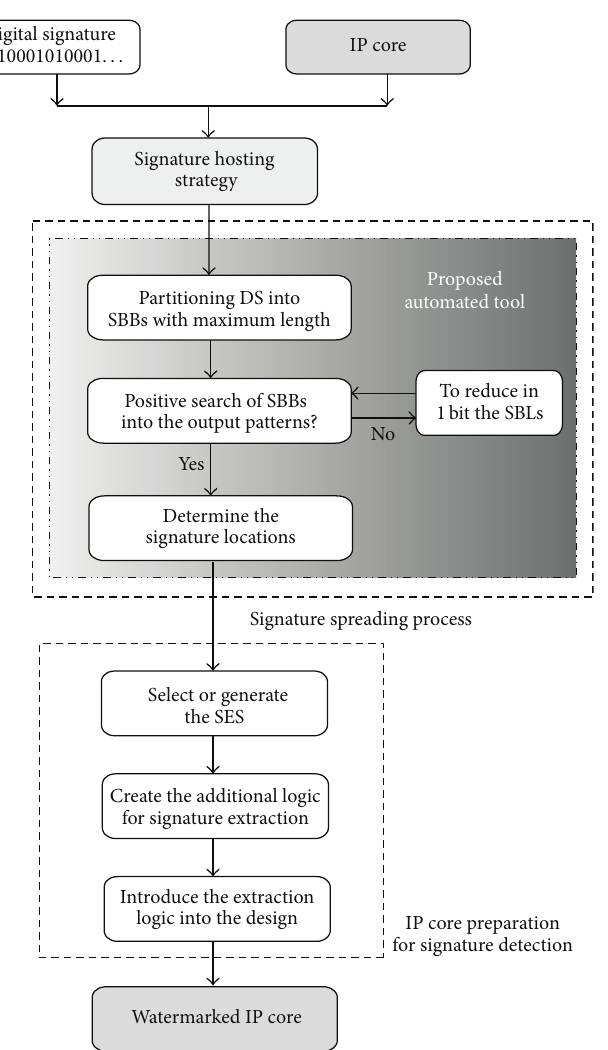
Figure 2: Generation of the watermarked IP core using